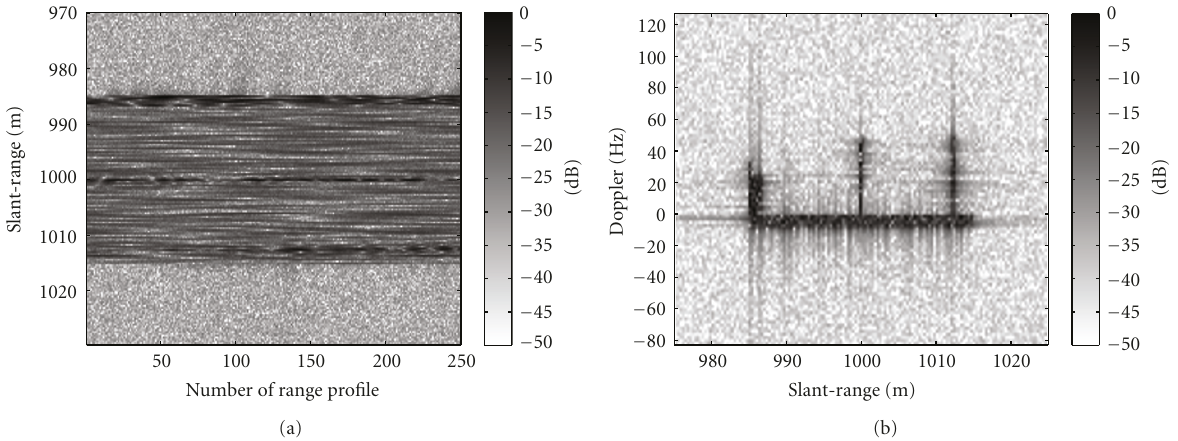
Figure 4: (a) Range profiles and (b) ISAR image for the simulated example without radial translational velocity.